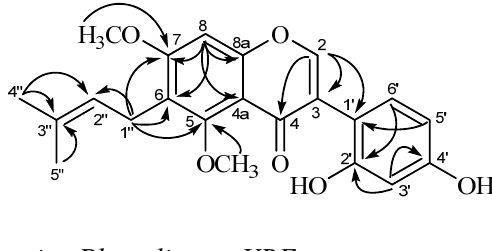
Figure 4. HMBC correlations observed for compound B (5,7-di- O -methylluteone, 32 ).